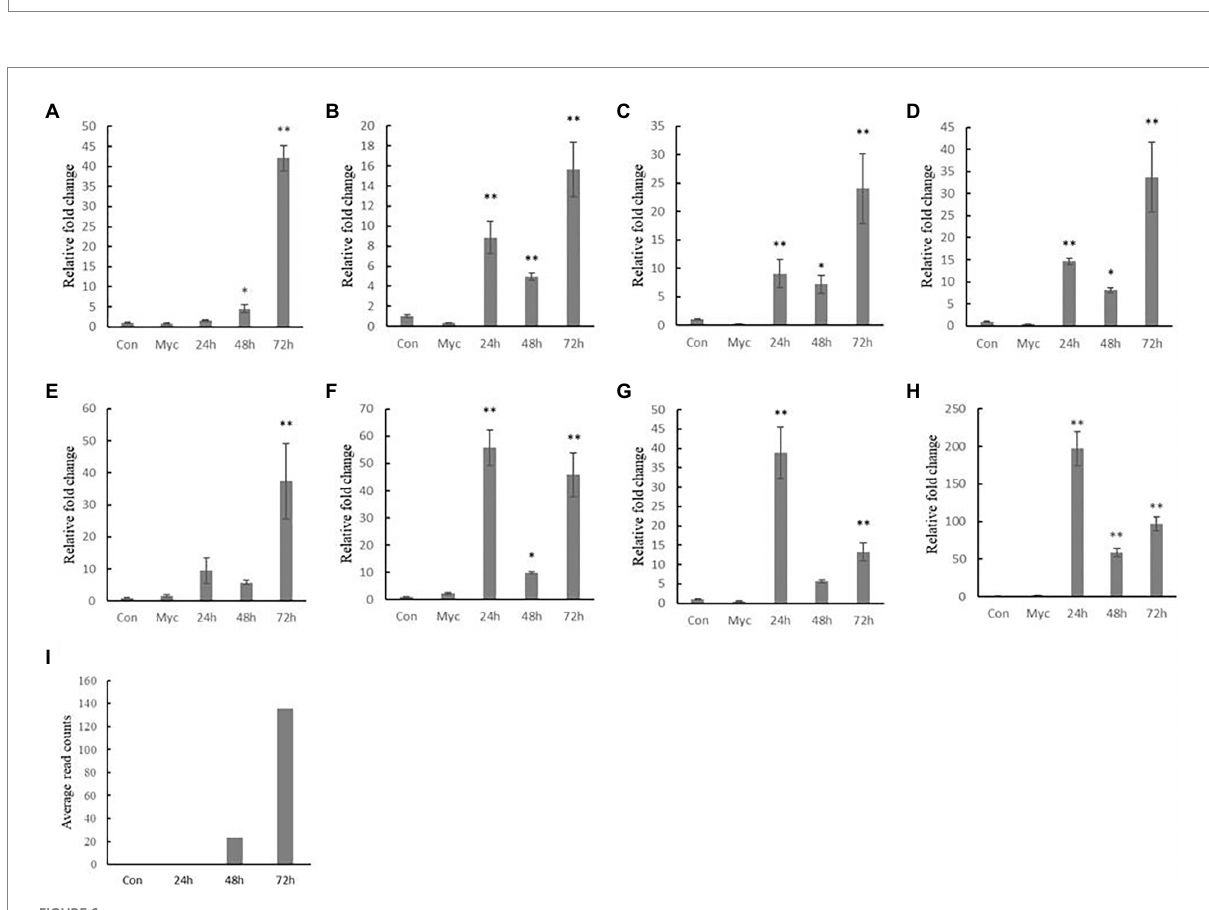
FIGURE 6 Expression profile of CfEP92 in Colletotrichum fructicola conidia and hyphal growth and during 24, 48, and 72 h infection of tea-oil leaves. (A) CfRrp ; (B) CfAct ; (C) CfTub ; (D) CfUce ; (E) CfRpp ; (F) CfCk ; (G) CfDd ; (H) CfAdrh ; and (I) CfEP92. Con means Conidia; Myc means Mycelium. The significance analysis was compared with the conidial stage. The data show the mean expression ± standard deviation calculated from three biological replicates. ∗ p < 0.05; ∗∗ p <